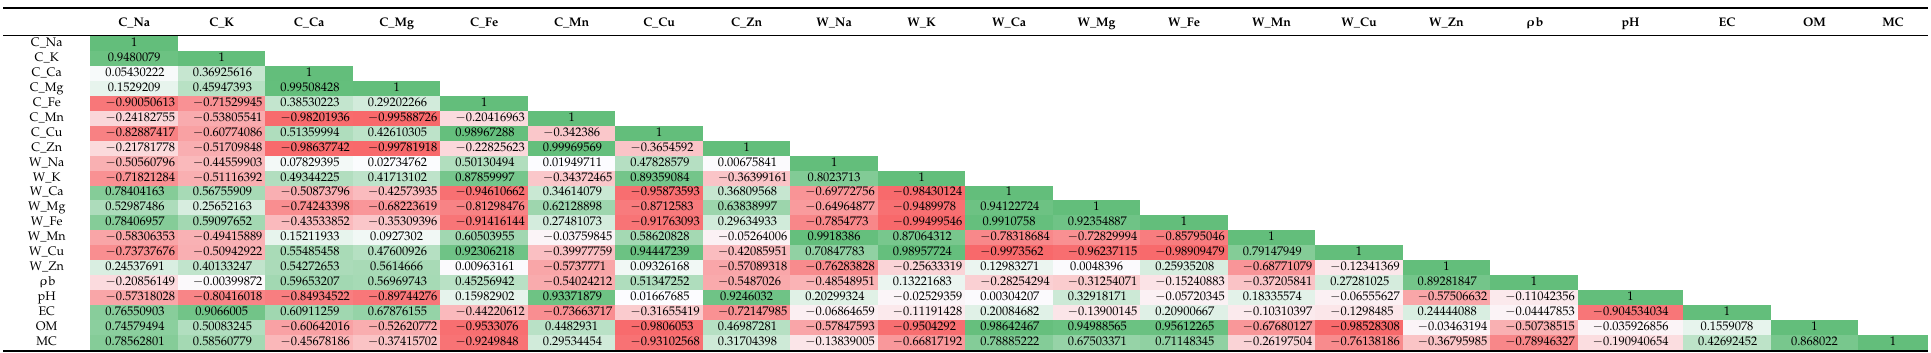
Table A4. Correlation coefficients between elemental composition nutrient content, water extractable nutrient content and physical and chemical properties of